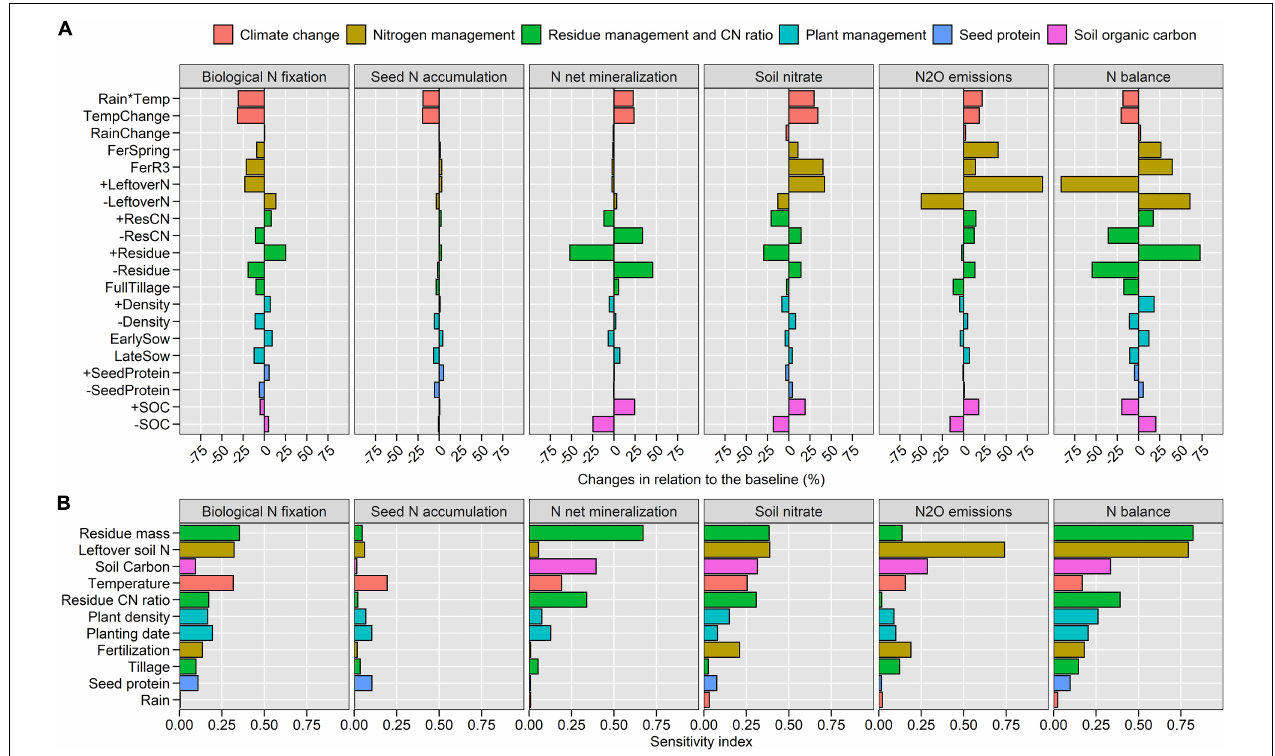
FIGURE 4 | Relative effects of climate change and management scenarios on soil-plant N dynamics compared to the baseline (A) and ranking of the importance of different GxExM variables with respect to N fluxes based on a sensitivity analysis (B) . Values were averaged over all locations and years. A summary table is also presented in Supplementary Table 6